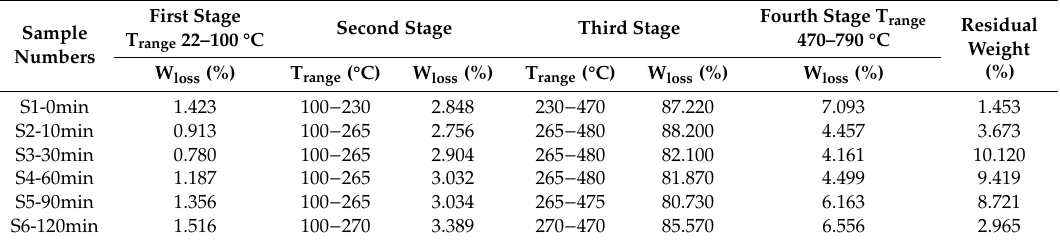
Figure 6. Thermogravimetric (TG) and DTG curves of unmodified and KH-560-modified jute fabrics and epoxy composites. (S1–S6 are samples with immersion times of 0, 10, 30, 90, and 120 min, respectively). Table 3. TG and DTG data from thermogravimetric analysis of unmodified and KH-560-modified jute fabrics and epoxy